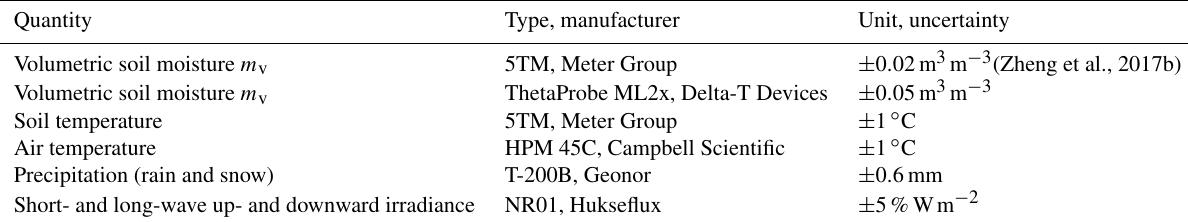
Table A1. Overview of relevant hydrometeorological sensors at the Maqu